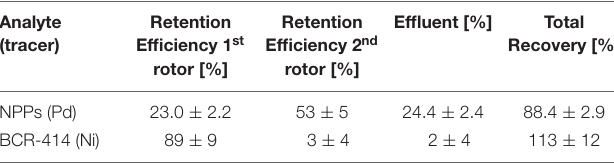
TABLE 2 | Retention efficiencies and recoveries for the Pd-doped NPPs and the plankton CRM BCR-414 for a sequential setup of two centrifuges operated at 4000 rpm and 17000